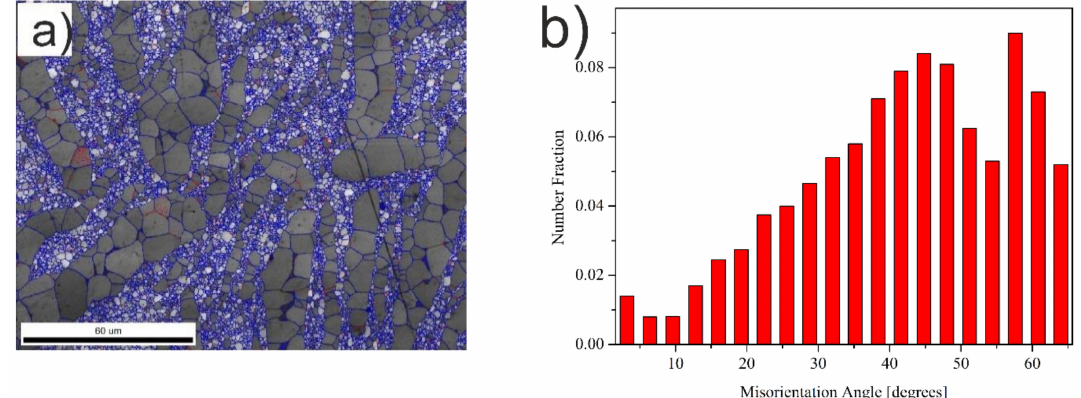
Figure 3. ( a ) Grain boundaries; ( b ) grains misorientation of the Ti + 20 wt %TiMoC composite. In contrast to the Ti + 20 wt %TiMoC (composite #3), the addition of carbon caused a significant evolution of the microstructure. In the Ti + 20 wt %TiMoC/C (composite #4), the uniform microstructure is clearly seen but a lot of pores are visible at the grain boundaries (Figure 4a,c). An average TiC grain size significantly increases in comparison to the composite #3. The most dominant are the coarse grains with average size of 8.5 µ m and 12 µ m (Figure 4b). In this case, the grains have a slightly different shape aspect ratio within the range 0.40–0.55 and 0.60–0.65.